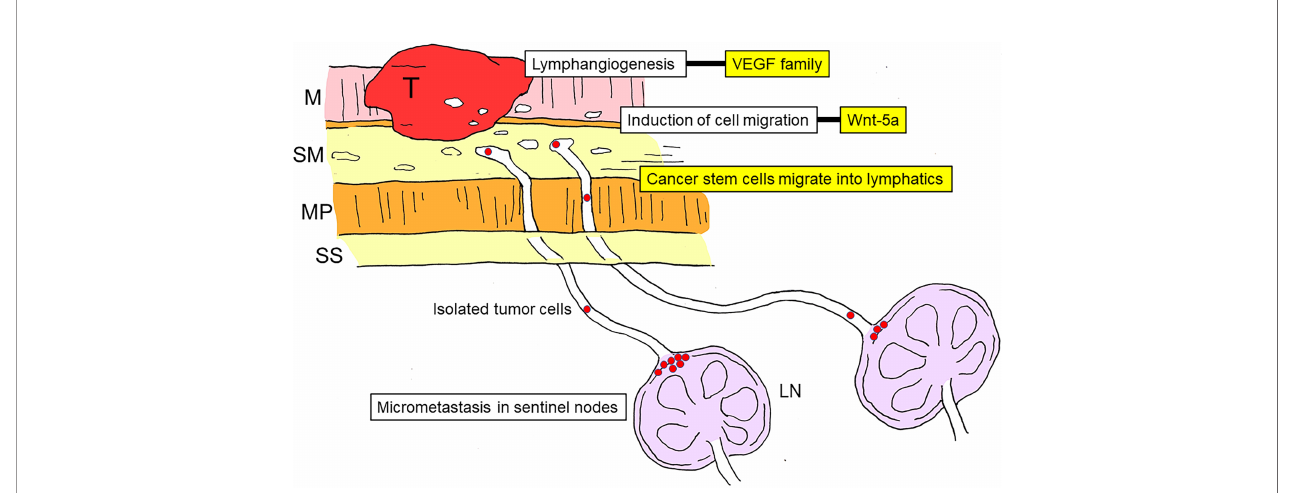
FIGURE 3 | Schematic diagram of the development and molecular mechanisms of nodal metastasis in gastric cancer. Lymph node metastasis can be divided into multiple stages: lymphangiogenesis, induction of cell migration, invasion of cancer stem cells into the lymphatic system, arrival of cancer stem cells in sentinel lymph nodes, and establishment of micrometastasis in the marginal sinus. The vascular endothelial growth factor (VEGF) family is involved in lymphangiogenesis, and Wnt- 5a is involved in the induction of cell migration. T, tumor; M, mucosal layer; SM, submucosal layer; MP, proper muscle layer; SS, subserosal layer; LN, lymph node; VEGF, vascular endothelial growth